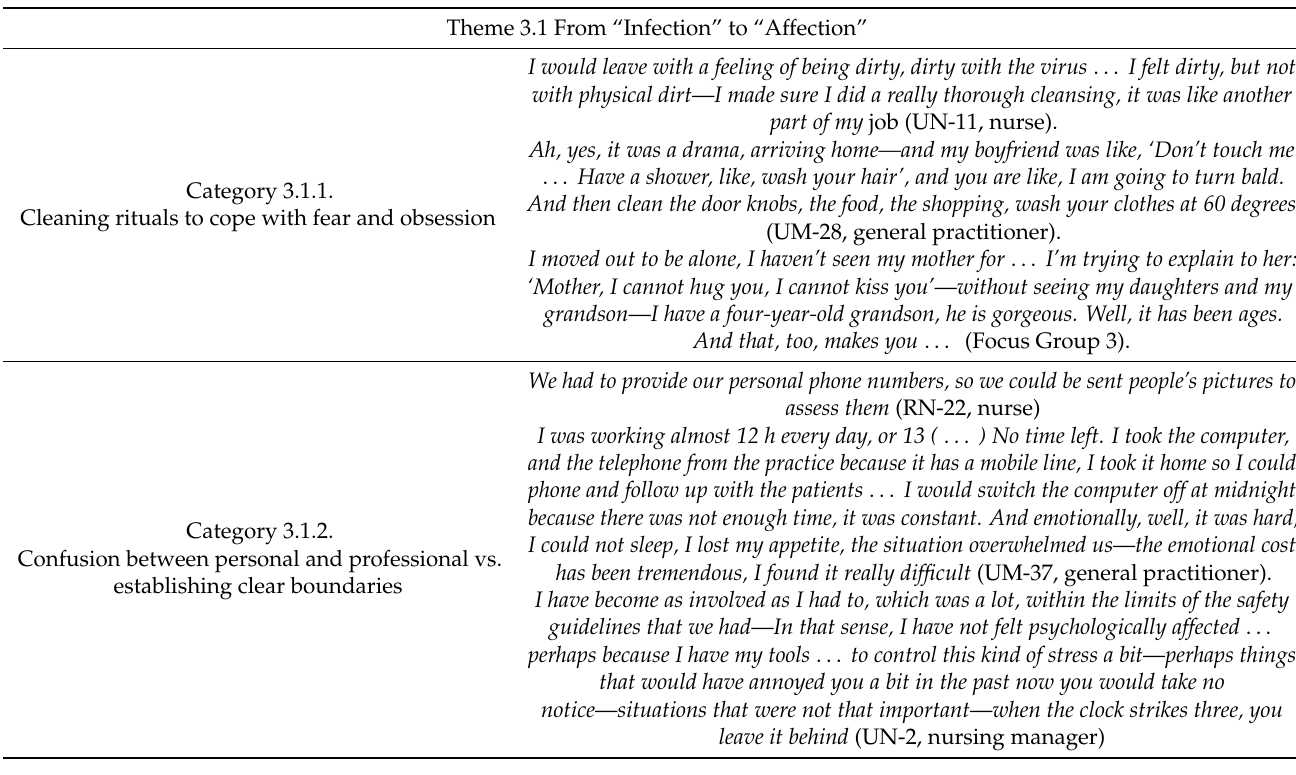
Table 3. Literal excerpts from the interviews and focus